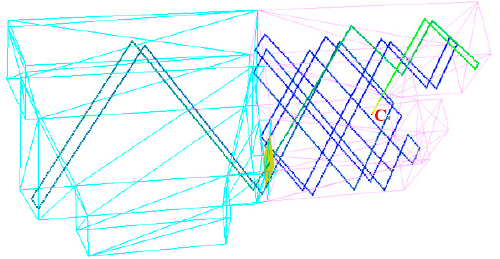
Figure 14. Principle of signal propagation (the signal intensity changes from strong to weak that corresponds to color from red to blue).